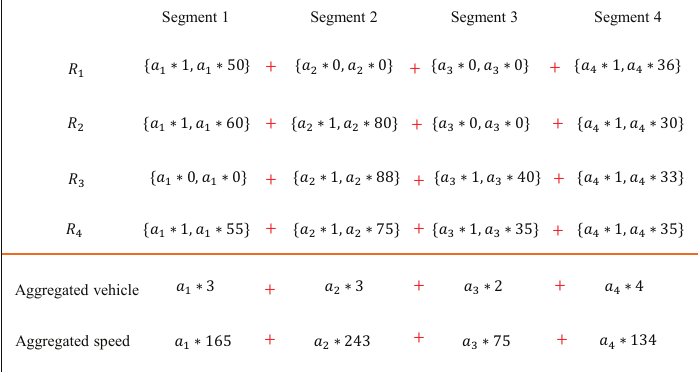
Figure 4. Traffic aggregation example in